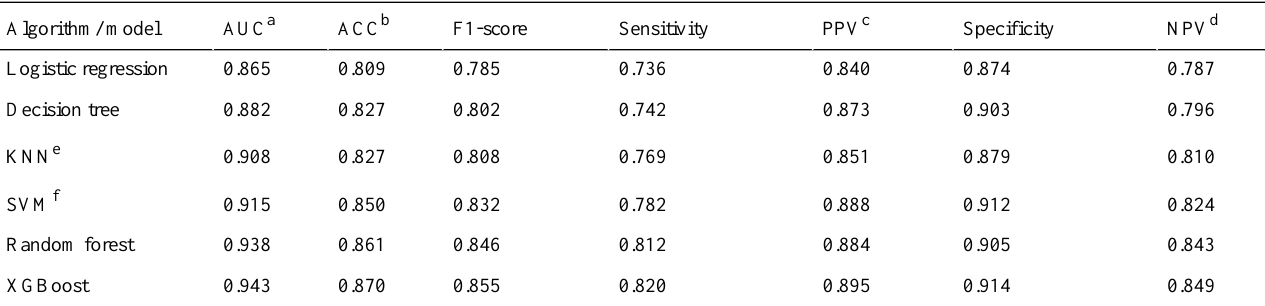
Table 4. Prediction scores of models created by different